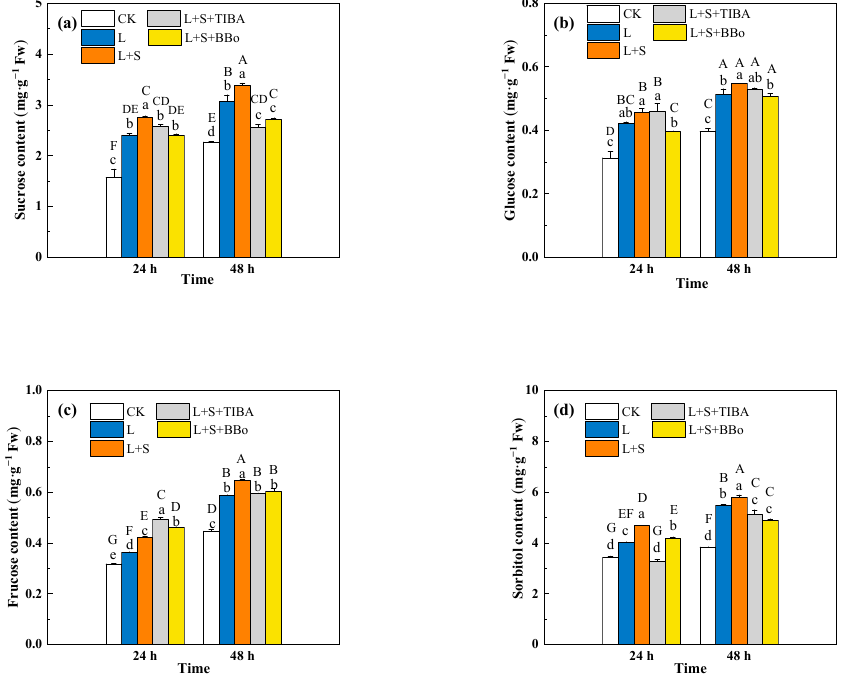
Figure 2. Effects of exogenous sucrose and IAA inhibitors on sucrose ( a ), glucose ( b ), fructose ( c ) and sorbitol ( d ) contents of M. baccata under sub-low temperature. Bars indicate means ± standard error ( n = 3). The lowercase letters represent significant differences between treatments ( p < 0.05). The capital letters represent significant differences between full data ( p < 0.05). The comparison of means is based on the Duncan’s multiple range test. CK, control treatment; L, sub-low root-zone temperature (5 °C); L + S, 5 °C + 90 mmol·L − 1 sucrose; L + S + TIBA, 5 °C + 90 mmol·L − 1 sucrose + 500 μ mol·L − 1 2,3,5-triiodobenzoic acid; L + S + BBo, 5 °C + 90 mmol·L − 1 sucrose + 300 μ mol·L − 1 4-biphenyl- boronic acid. (See Supplementary Materials).